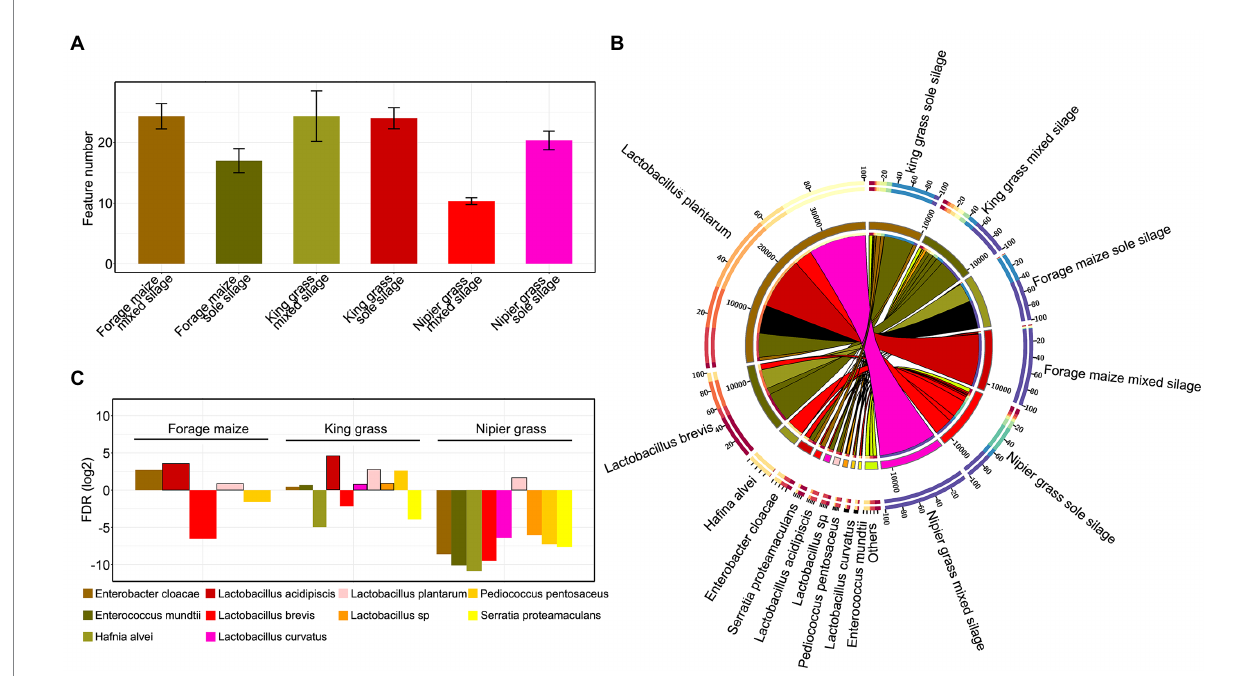
FIGURE 1 Patterns of relative abundance of bacterial communities between samples. (A) Feature numbers of operational taxonomic units (OTUs) in each sample. (B) Distribution of the 10 most abundant bacterial species of silages. The bar length on the outer ring represents the percentage of each species in each sample. (C) The ratio of log2 fold change in the relative abundance of bacterial taxa in mixed silages compared with sole silages as control. The quantity of OTUs was normalized to